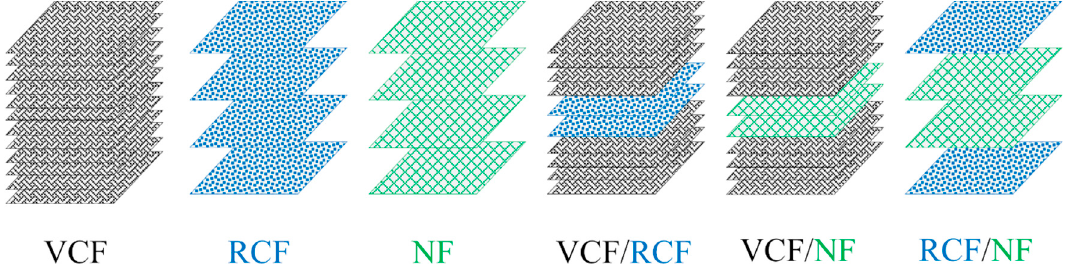
Figure 1. Stacking sequence of pure and hybrid laminates. Table 1. Summary of fiber reinforced plastic